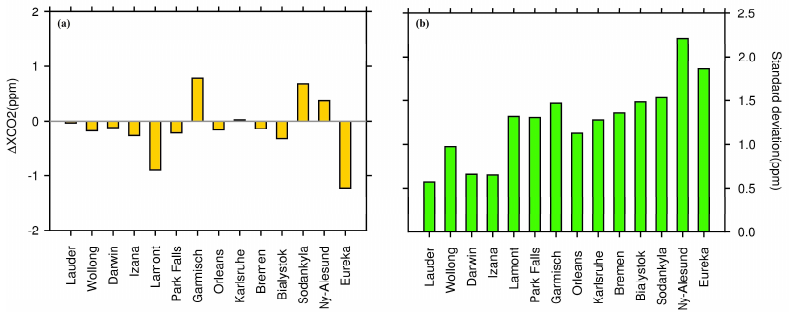
Figure 10. Bias and root-mean-square error (RMSE) of GEOS-Chem model vs. TCCON sites in 2010. ( a ) model bias; ( b ) RMSE. Unit: ppm.